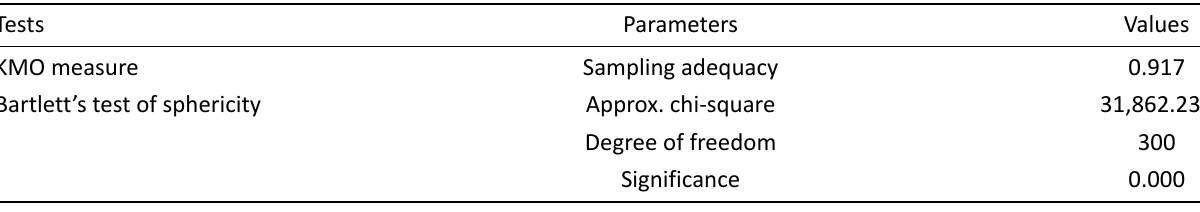
Table 4. KMO and Bartlett’s